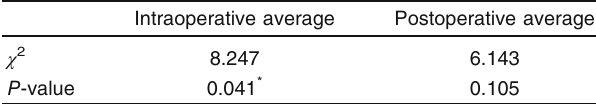
Table 3 Comparison between intraoperative and postoperative telemetry average of the four electrodes by Kruskal – Wallis test